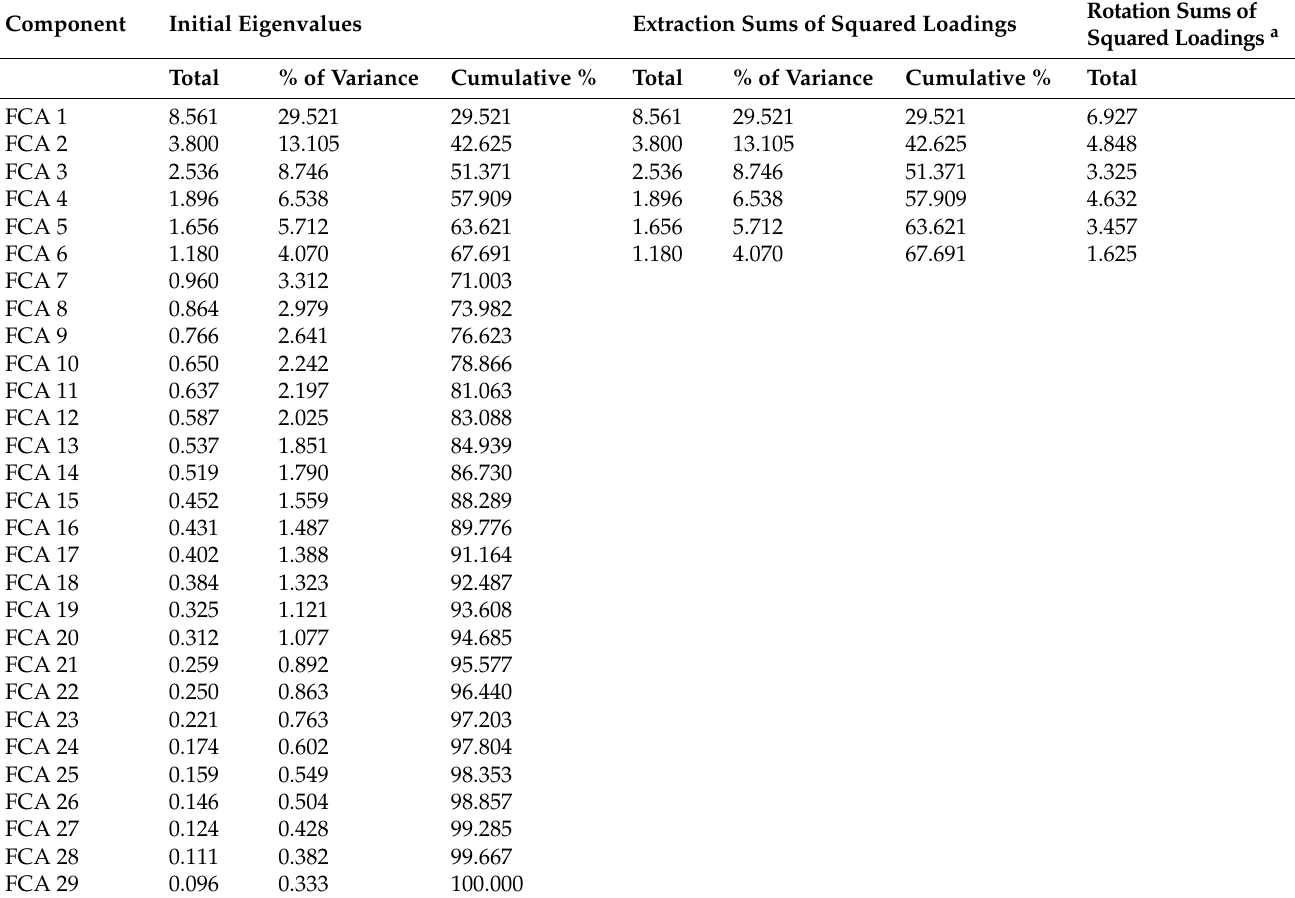
Table 4. Total variance explained.